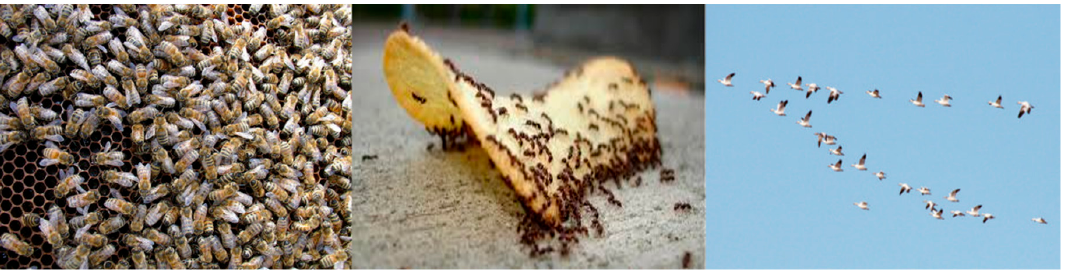
Figure 1. Examples of swarms